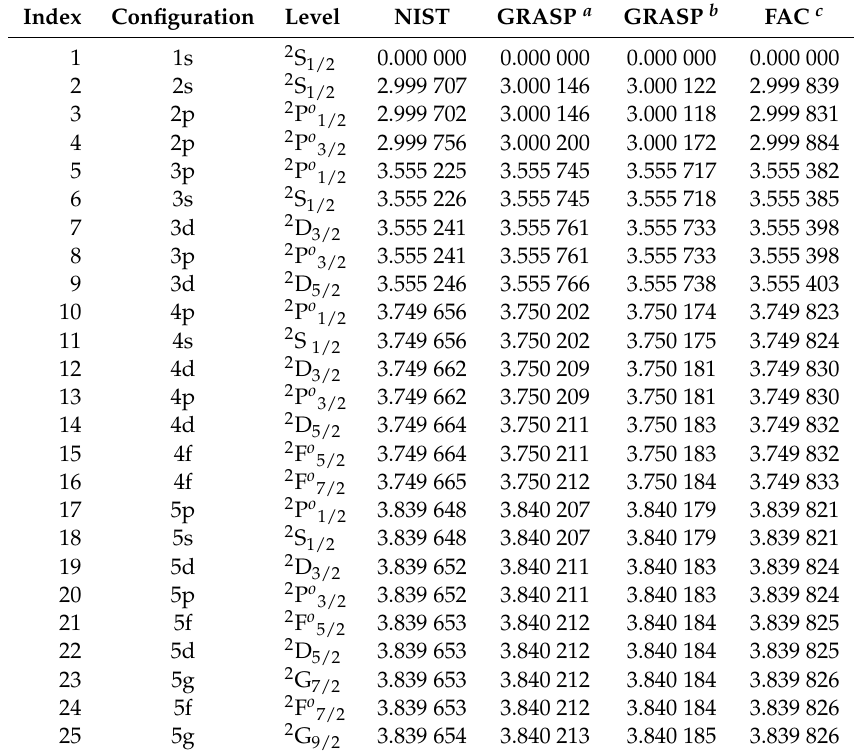
Table 1. Energy levels (in Ryd) of He